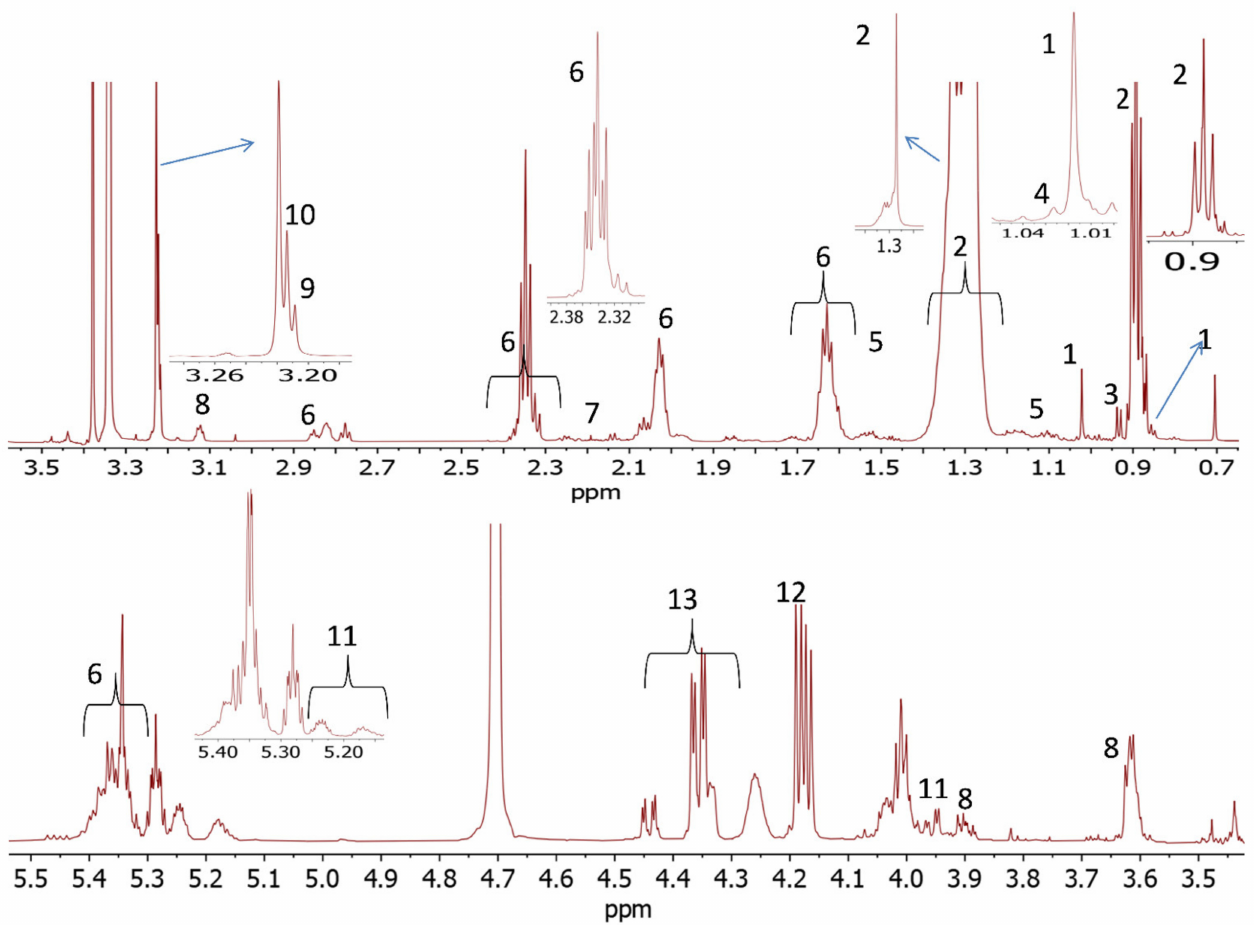
Figure 1. 700 MHz 1 H NMR spectrum of nonpolar extract of Dorper sheep longissimus dorsi muscle tissue: 1. free cholesterol, 2. sphingomyelin, 3. total cholesterol, 4. esterified cholesterol, 5. multiple cholesterol protons, 6. fatty acyl chain, 7. succinate, 8. creatine, 9. glycerophosphocholine, 10. choline, 11. glycerophospholipid backbone, 12. glycerol backbone and 13. phosphatidyl